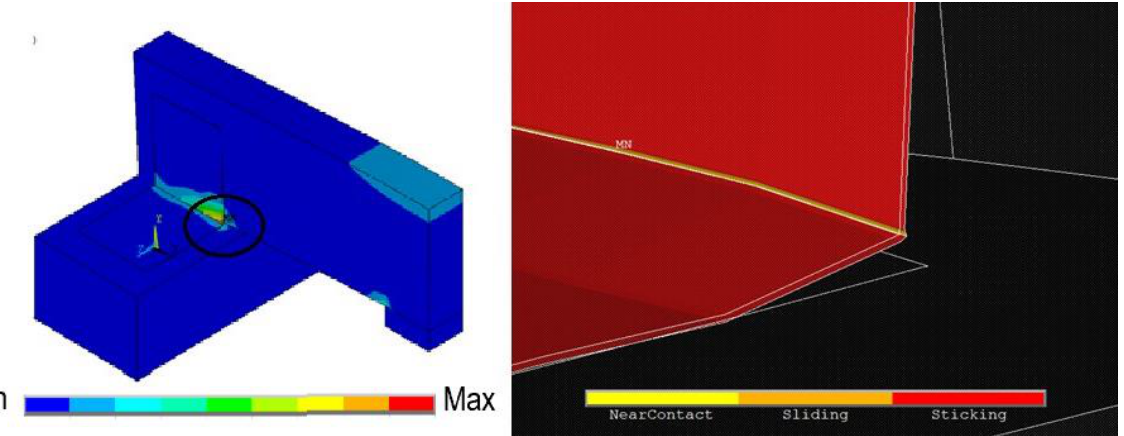
Figure 6. Delamination of FRP from wood.